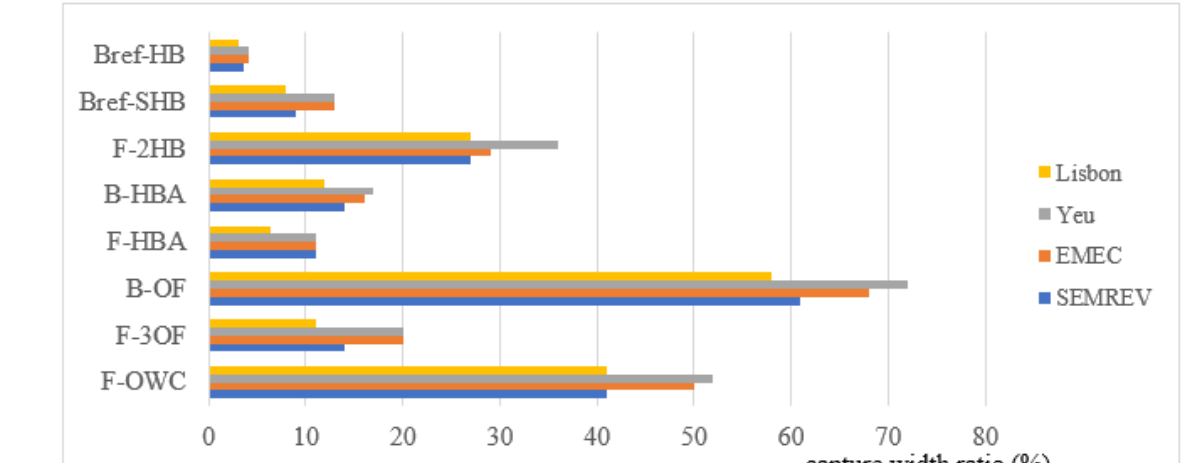
Figure 1. Performance comparison of the capture width ratio of different WECs.